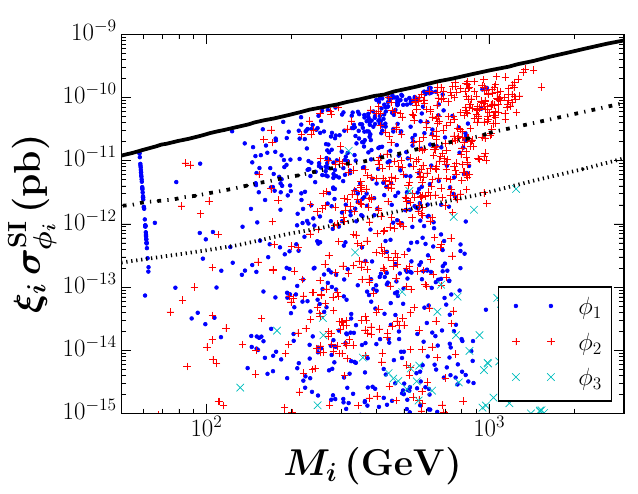
Figure 6 . Detection prospects in the scan with µ S 1 , µ S 2 , µ S 3 6 = 0 (B). The solid line is the current LZ limit whereas the dash-dotted and dotted lines correspond to the expected sensitivities of LZ and DARWIN